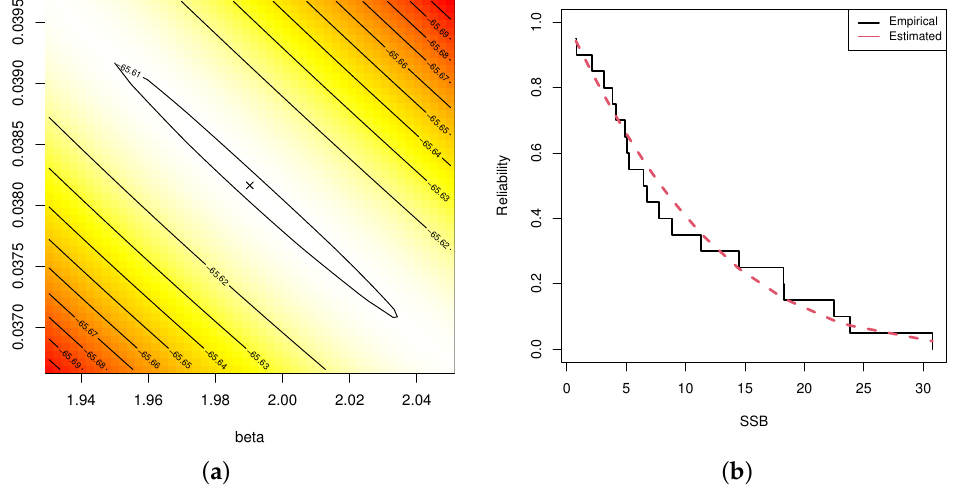
Figure 7. ( a ) Contour plot of β and θ and ( b ) fitted/empirical RFs (right panel) from SSB data.